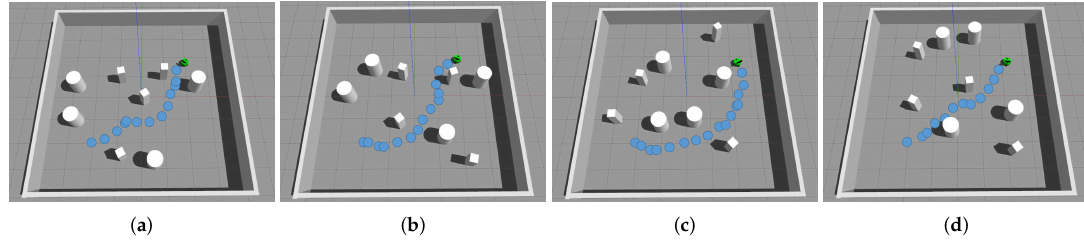
Figure 14. The schematic diagram of the trajectory of the robot generated by the learning Map-based policy using the depth camera in four simulation environments ( a – d ) with 8 randomly placed